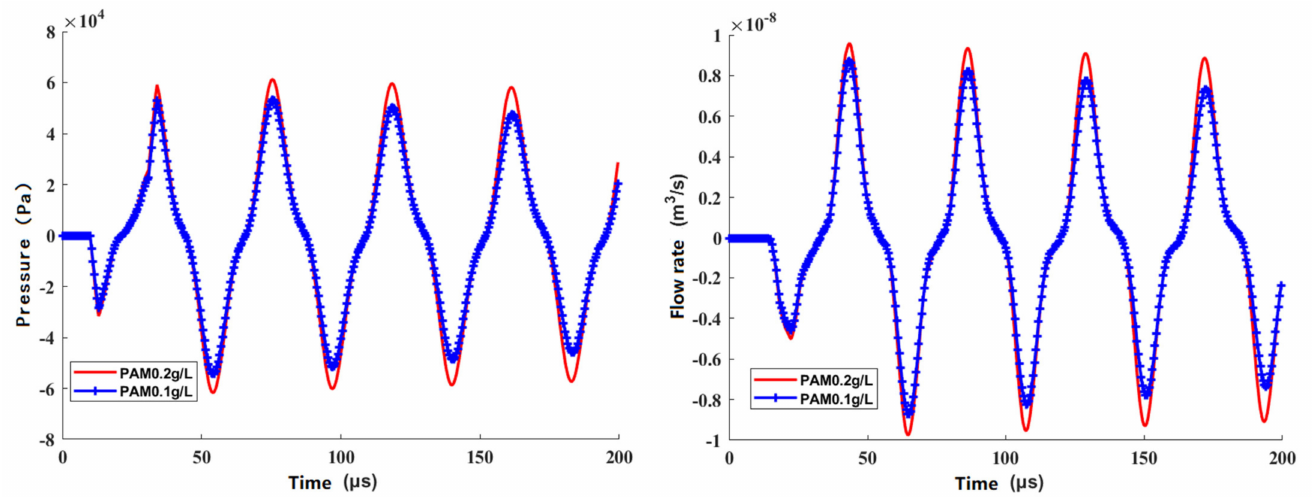
Figure 7. Results of the proposed